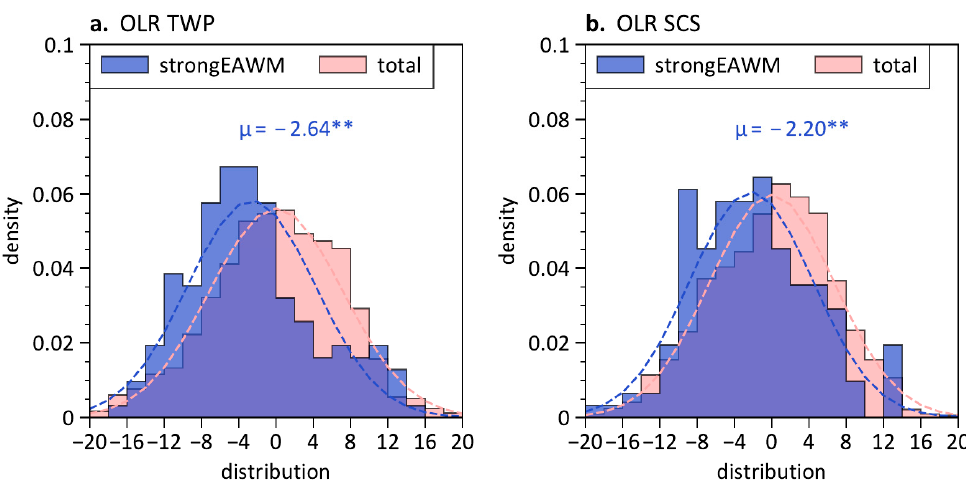
Figure 5. Distributions of the area-averaged OLR anomaly for days 0–2 of the strong EAWM events (blue) and for the whole period (red). ( a ) For the region of WTP (15 ◦ S–15 ◦ N, 100 ◦ –130 ◦ E, red box in Figure 3); ( b ) for the region of South China Sea (0 ◦ –20 ◦ N, 100 ◦ –120 ◦ E, denoted as SCS). µ in ( a , b ) indicates the mean of the TWP-averaged and SCS-averaged OLR anomalies during days 0–2 of the strong EAWM events, respectively. Double asterisk (**) indicate the anomalies exceed the 95% confidence level.